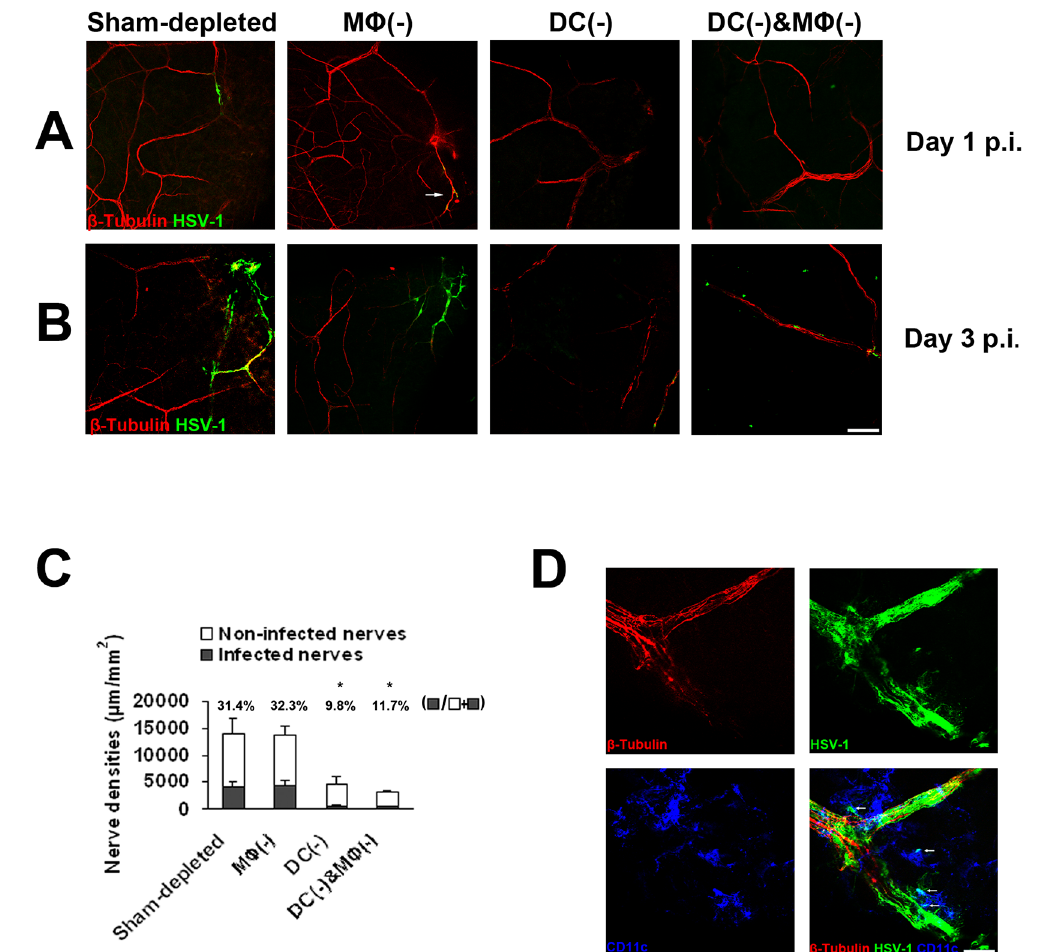
Fig 5. Corneal nerves demonstrate delayed and decreased HSV-1 infection in conventional dendritic cell-depleted corneas. After corneal depletion of cDCs or/and M Φ s, or sham depletion, infected corneas (n = 5) were collected for immunohistochemistry studies. A: As early as day as 1 p.i., peripheral corneal nerves co-stained with HSV-1 in sham-depleted or M Φ depleted corneas, while depletion of corneal cDC resulted in no corneal nerve staining with HSV-1. B, C: On day 3 p.i., the percentage of infected nerves was significantly lower with cDC depletion as compared to sham controls and M Φ depleted corneas. D: The representative micrographs show that infected cDCs (arrows) were located adjacently to the infected nerves. Each experiment was replicated three times. * p < 0.05 compared with sham-depleted (chi-square test). Data are shown as mean ± SD. Scale bar: 100 μ m (A, B); 50 μ m (D).